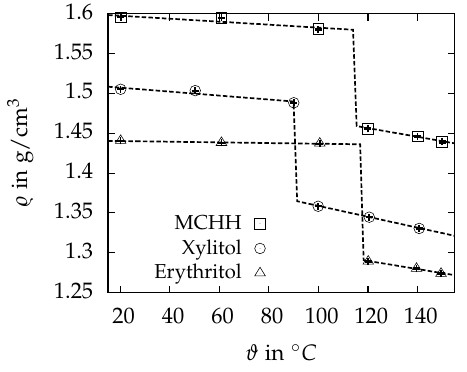
Figure 9: Density $ as a function of the temperature ϑ of the Figure 7. Density (cid:36) as a function of the temperature ϑ of the investigated PCM. The dashed line investigated PCM. The dashed line represents the linear fit of the measured points. represents the linear fit of the measured Figure 10: Results of the cycling test with MCHH. Magnesiumchloride hexahydrate has the highest density of 1.5955 0.0002g/cm 3 at 20 ◦ C, followed El-Sebaii et al. [27, 28] have reported stronger ± by xylitol and erythritol with 1.5050 0.0004g/cm 3 fluctuations of the melting temperature and the melt- ± and 1.4404 0.0005g/cm 3 , respectively. The results ing enthalpy, but they used larger samples and hence ± are in good agreement within 3% with the values segregation effects may appear stronger.